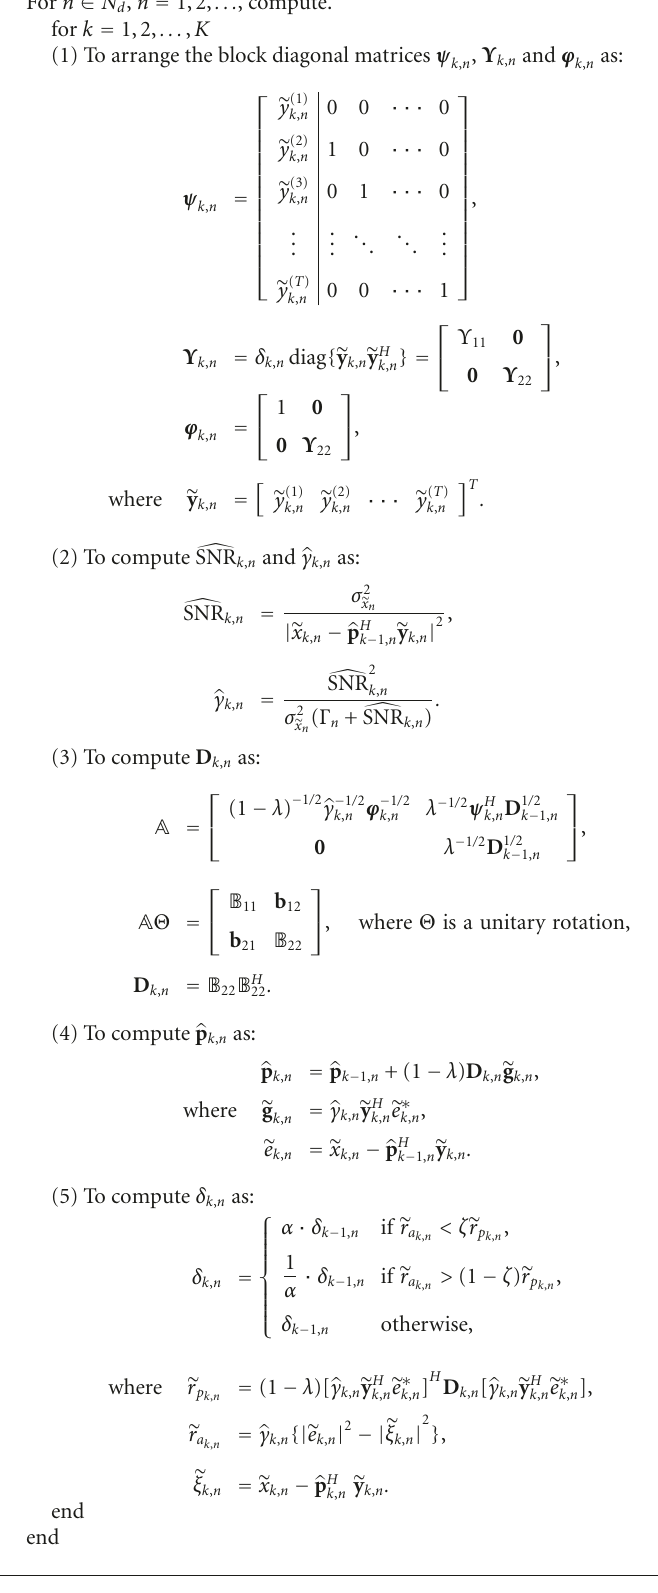
Algorithm 1: Summary of the proposed adaptive iQRRLM-based